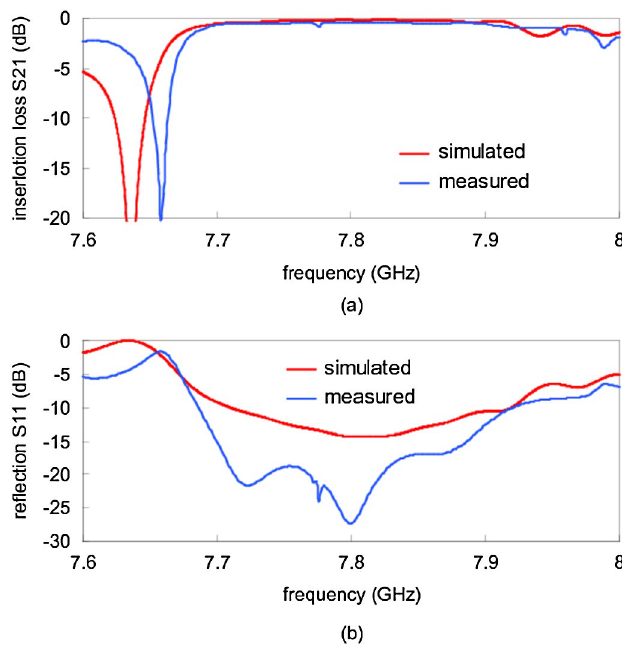
FIG. 8. (Color) Comparison of the measured and simulated and reflection S coefficients (mode transmission S 21 11 ; FIG. 9. (Color) Simplified diagram of the AWA beam line used launcher-rf output coupler assembly). (a) Insertion loss S 21 . (b) reflection S during the beam 11